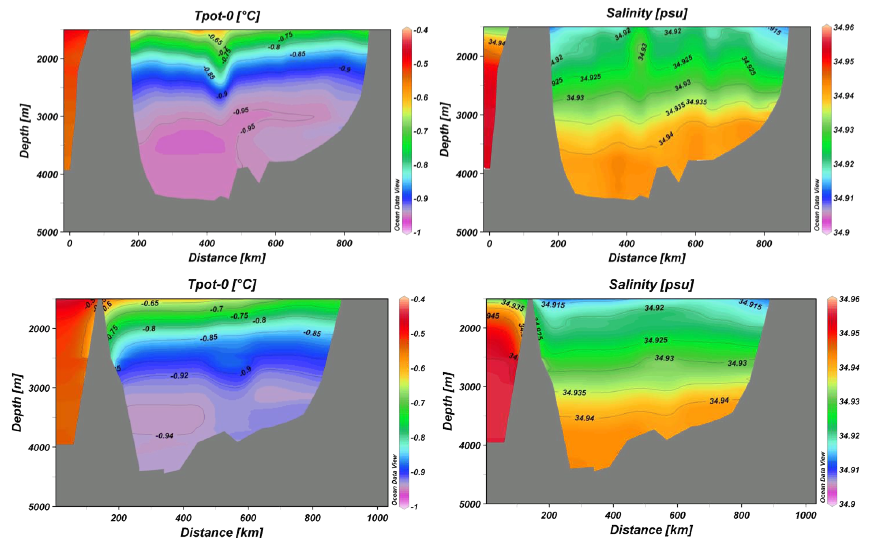
Fig. 22 . Potential temperature and salinity sections across the Eurasian Basin taken in 1996 (upper panel) and 2007 (lower panel.) showing the temperature increase, and a possible salinity decrease, below 1500m. The mean temperature difference is estimated at 0.015 ◦ C.